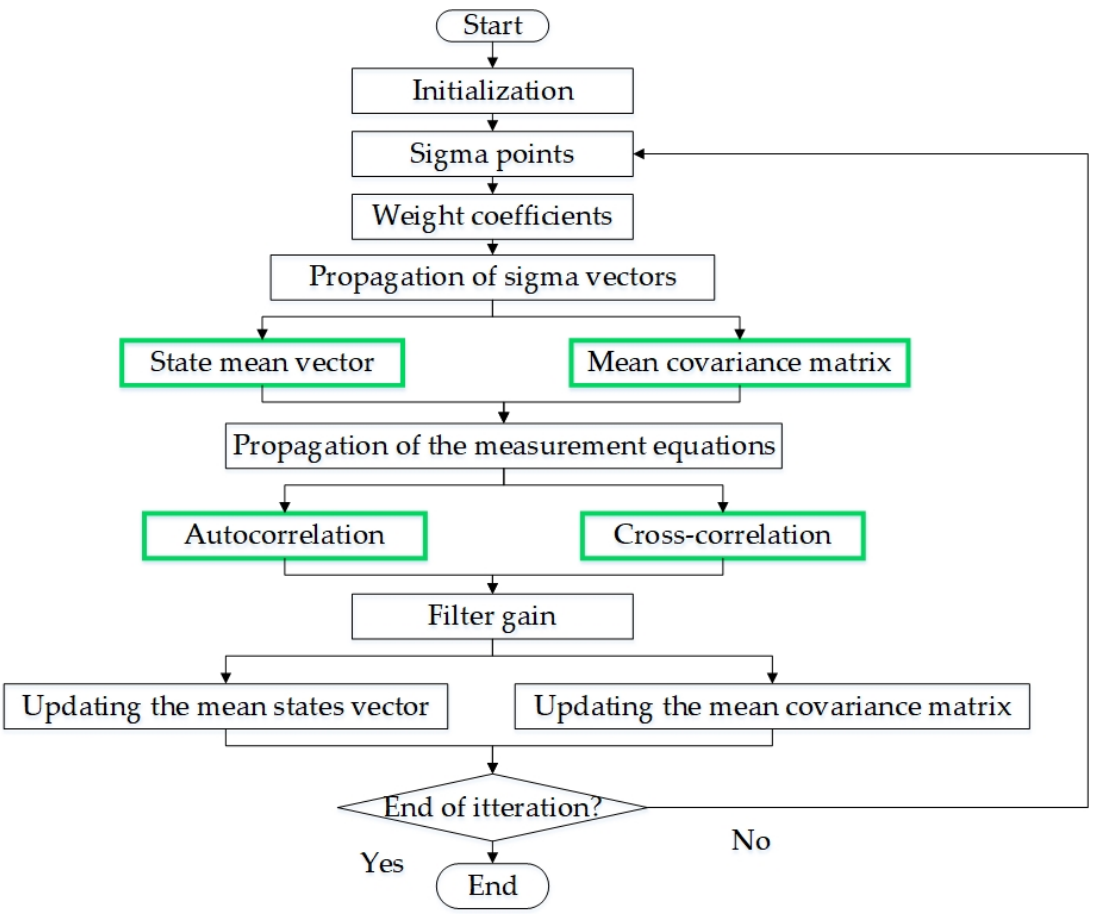
Figure 3. The flowchart of the proposed method. (The boxes with the green borders indicate the main improvements of the proposed method.)